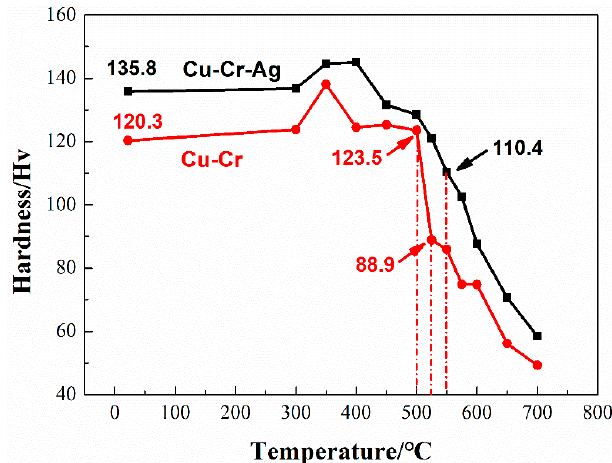
Figure 2. Hardness of test alloys at different annealing temperature levels for 1 h.